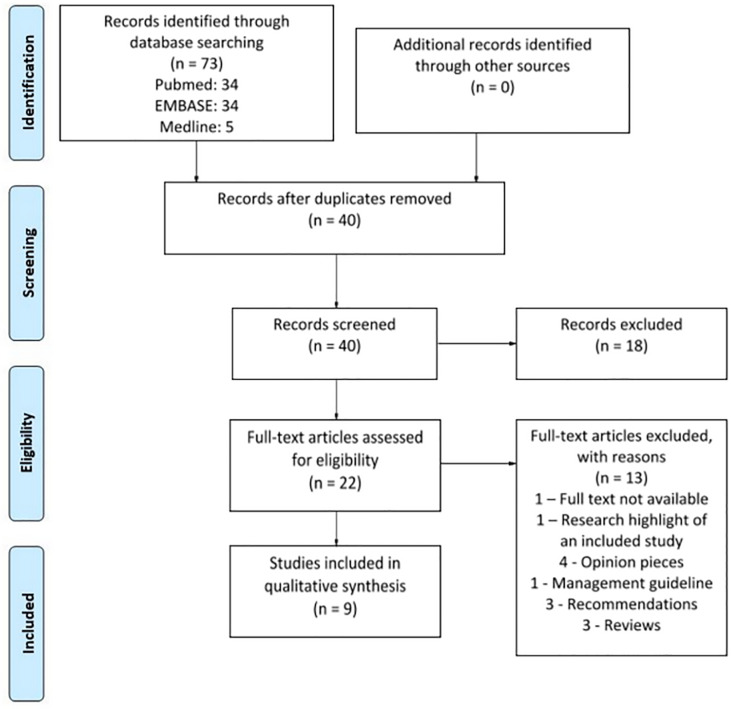
PRISMA flow diagram.